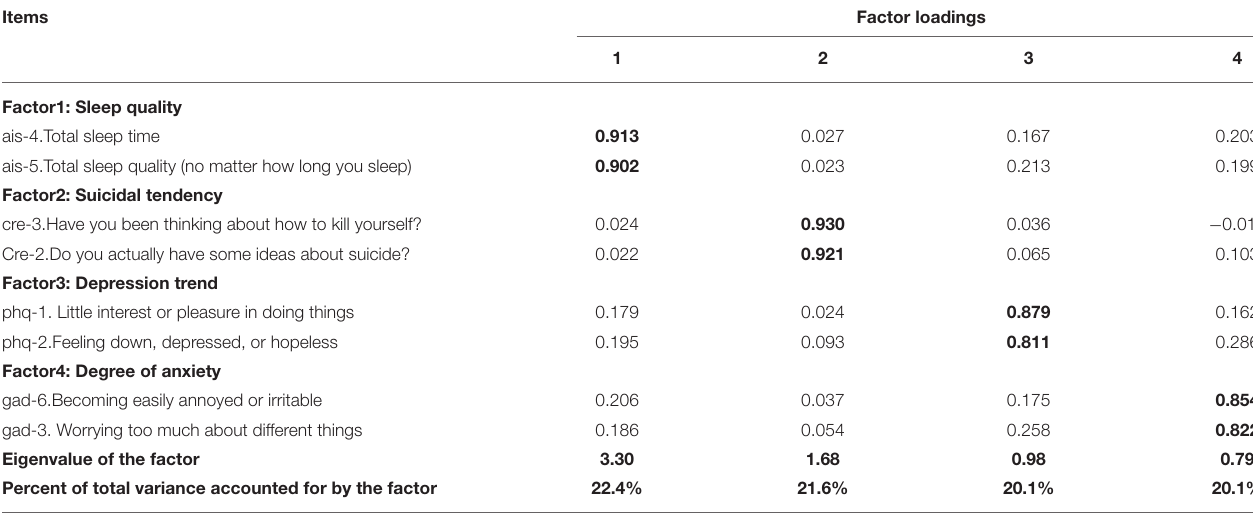
TABLE 2 | Results of exploratory factor analysis (among 458 patients) of the 4-factor model of the Happiness Index Scale (HIS). Items